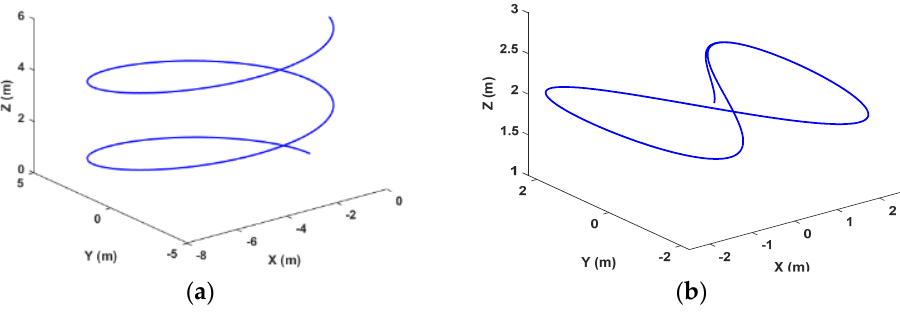
Figure 4. UAV trajectory: ( a ) helical trajectory, ( b ) infinity trajectory.